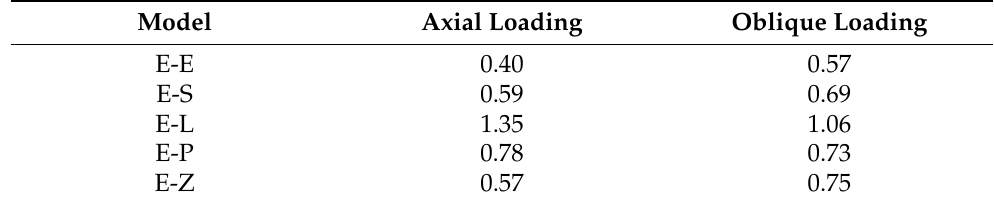
Table 5. The Mohr–Coulomb ratio in cement layer in the models when axial and oblique loadings were applied. Model Axial Loading Oblique Loading E-E